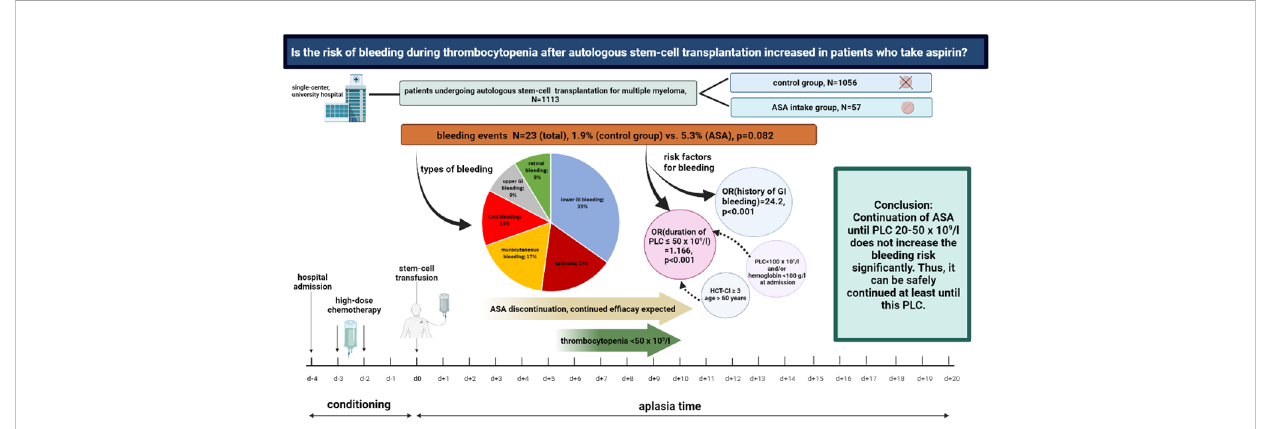
FIGURE 5 Aspirin use and bleeding events during thrombocytopenia following autologous stem-cell transplantation for multiple myeloma. Overview on the study design and major fi